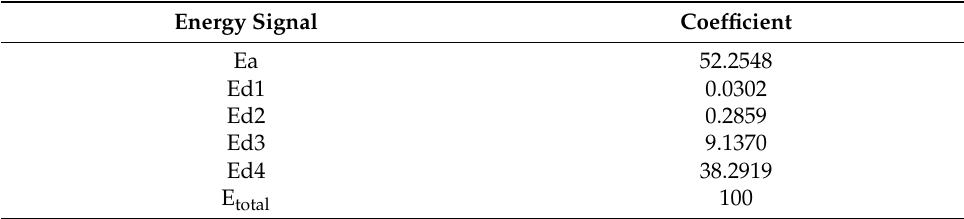
Figure 8. Signal current in the frequency domain of the motor; the status is not connected to the load. Table 2. The calculation energy coefficient of stator current signal in normal condition.